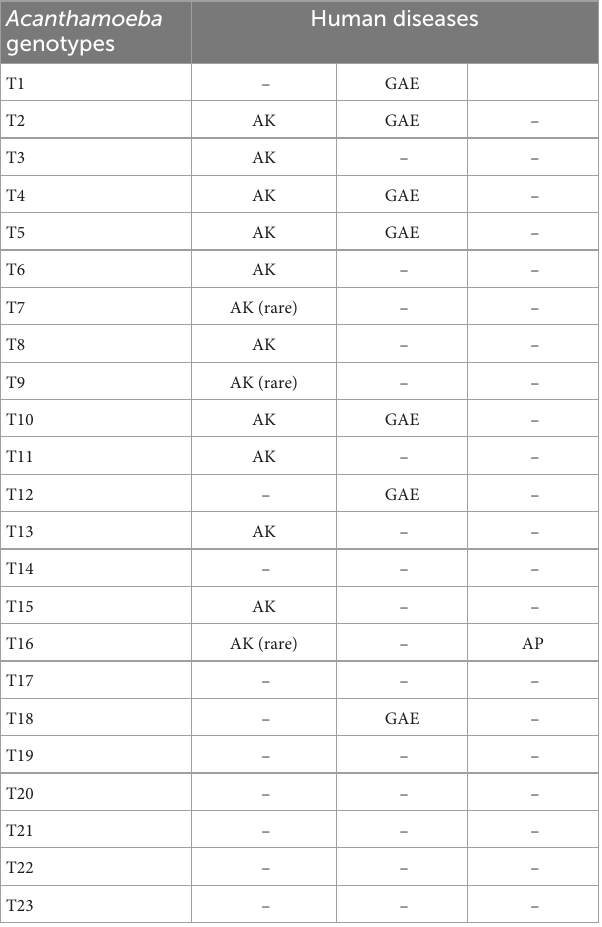
TABLE 2 Known Acanthamoeba genotypes and associations with human